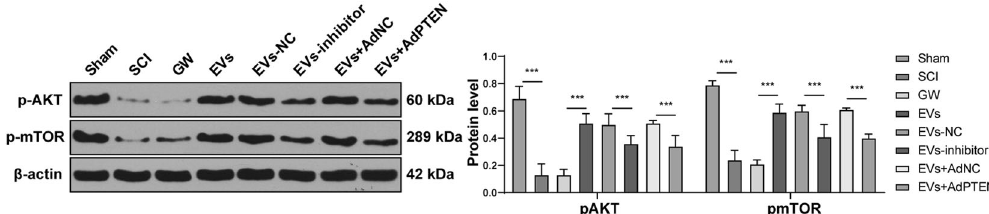
Fig. 7 HucMSCs-EVs activate the Akt/mTOR pathway during SCI repair in rats via the miR-29b-3p/PTEN axis. The expression and phosphorylation of Akt and mTOR in the Akt/mTOR signaling pathway were detected using Western blotting. N = 6. Data are expressed as mean ± standard deviation and analyzed and analyzed using two-way ANOVA, followed by Tukey ’ s multiple comparisons tests, *** p <